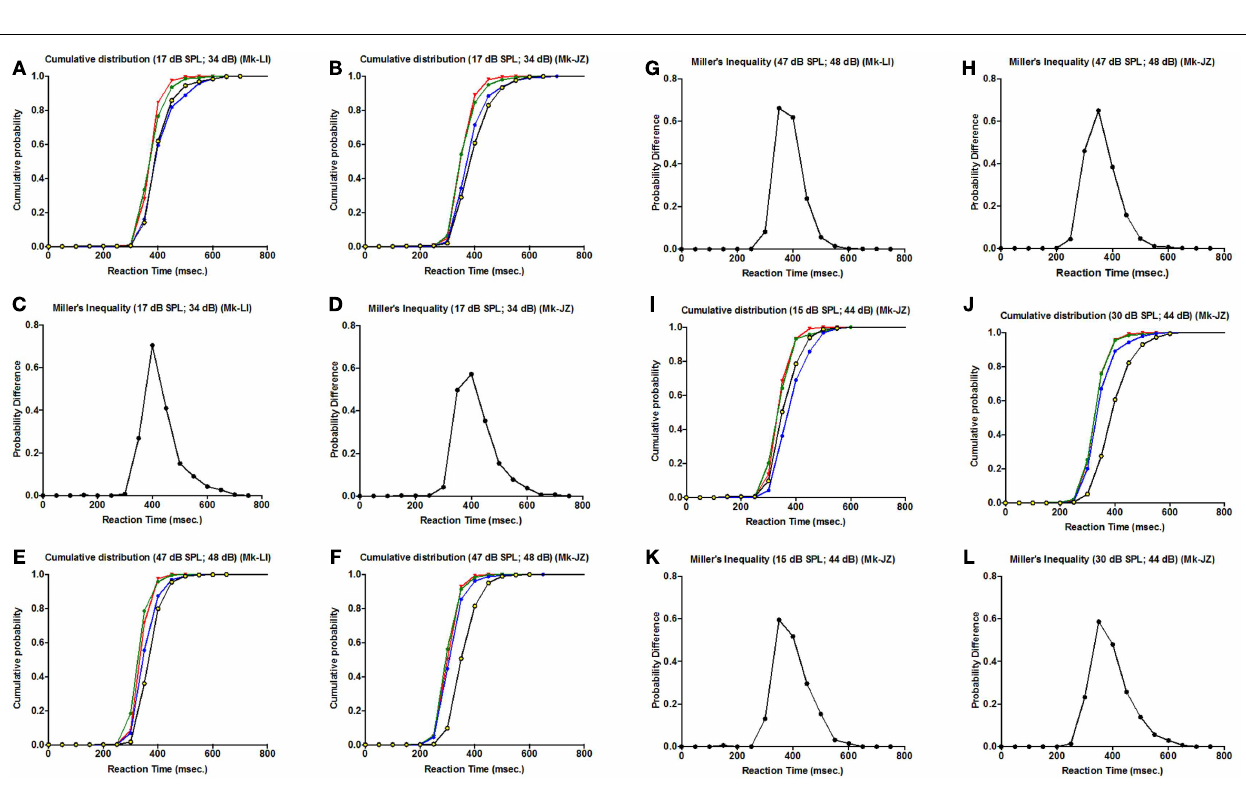
FIGURE 6 | Cumulative distribution function for different intensities for both monkeys (Mk-LI and Mk-JZ) . (A,B,E,F,I,J) are for the cumulative distribution functions for Mk-LI (A,E) and for Mk-JZ (B,F,I,J) . (C,D,G,H,K,L) are for the Miller’s Inequality for Mk-LI (C,G) and for Mk-JZ (D,H,K,L) . In the